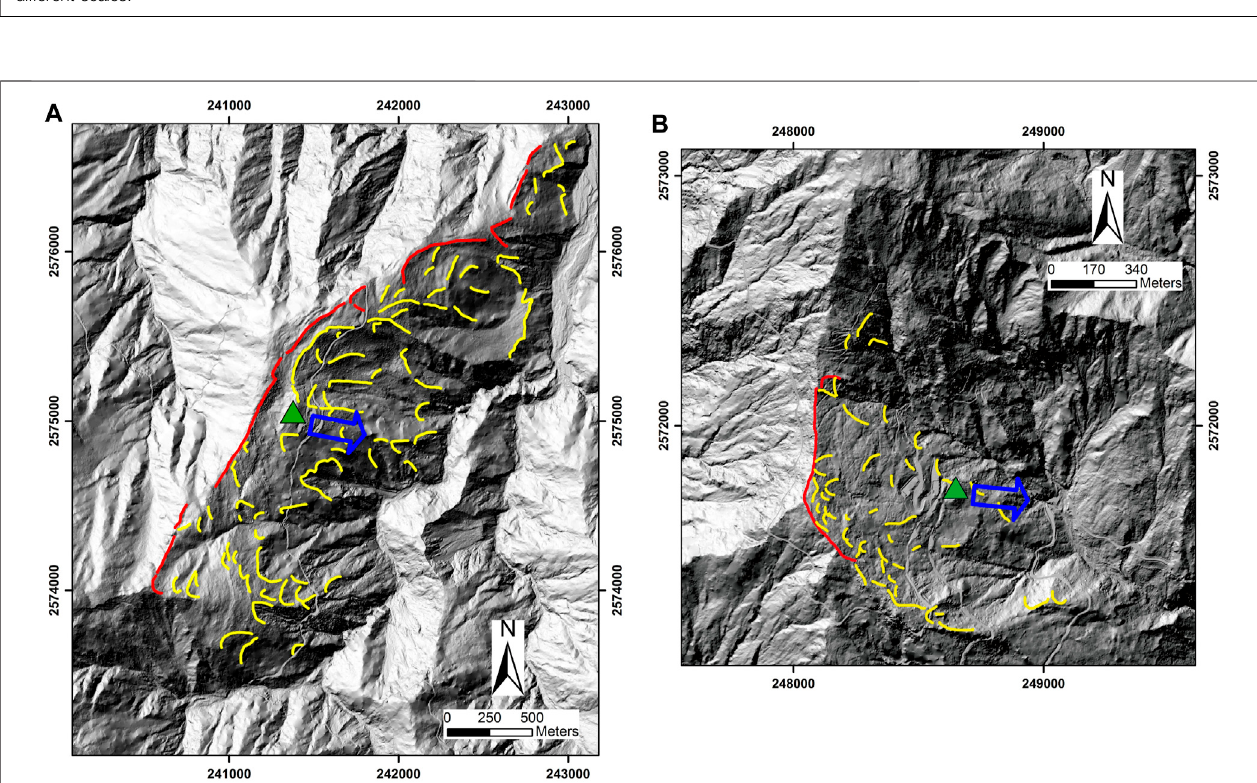
FIGURE 4 | LiDAR image of topographic characteristics of the (A) TienChih and (B) SiangYang sites. Red thick line: main cracks, yellow lines: minor cracks. The GPS recorded sliding direction, 8/7/2009 ∼ 8/12/2009, is marked by the blue arrow.